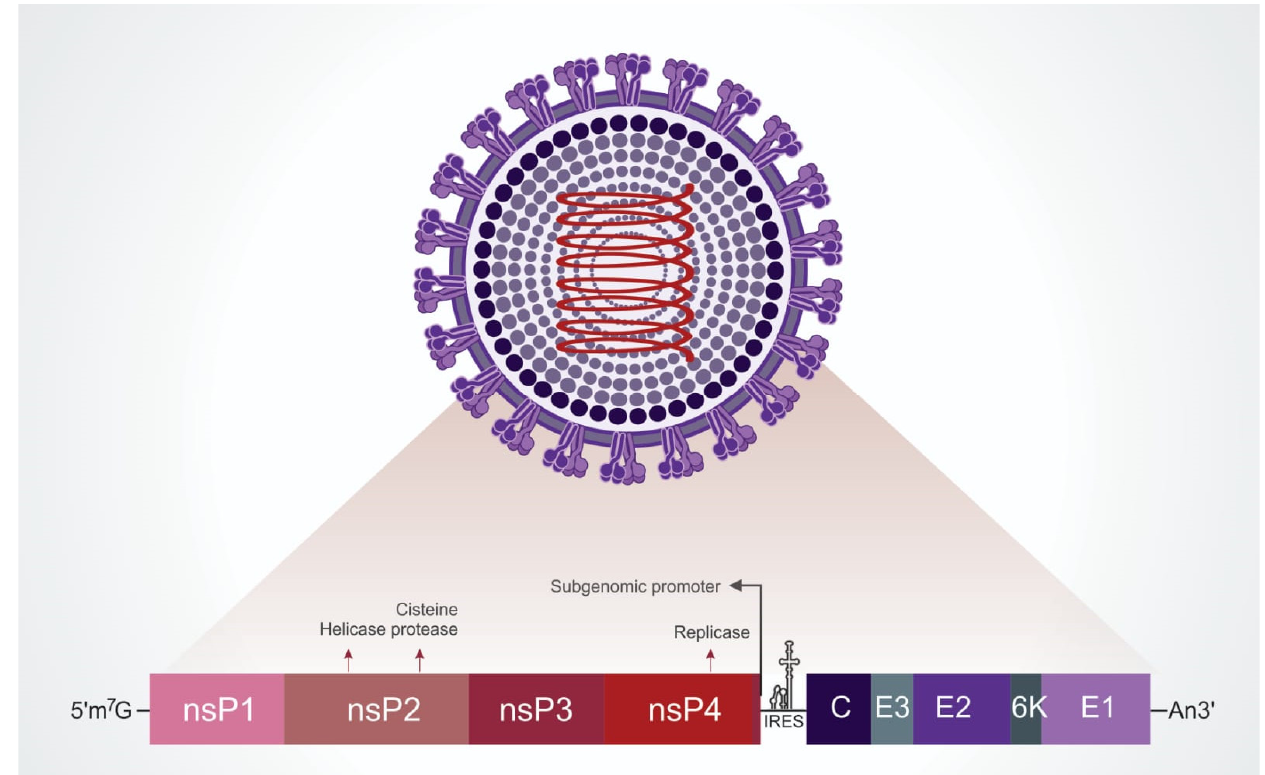
Figure 1. Schematic representation of MAYV particle and genomic organization. Electron microscopy data [41] shows that the viral particle is about 70 nm in diameter, constituted of structural proteins (in purple scale: C—capsid; E1—envelope glycoproteins 1; E2—envelope glycoproteins 2; E3—envelope glycoproteins 3; 6K—protein that associates E1 and E2). In addition to these, non-structural